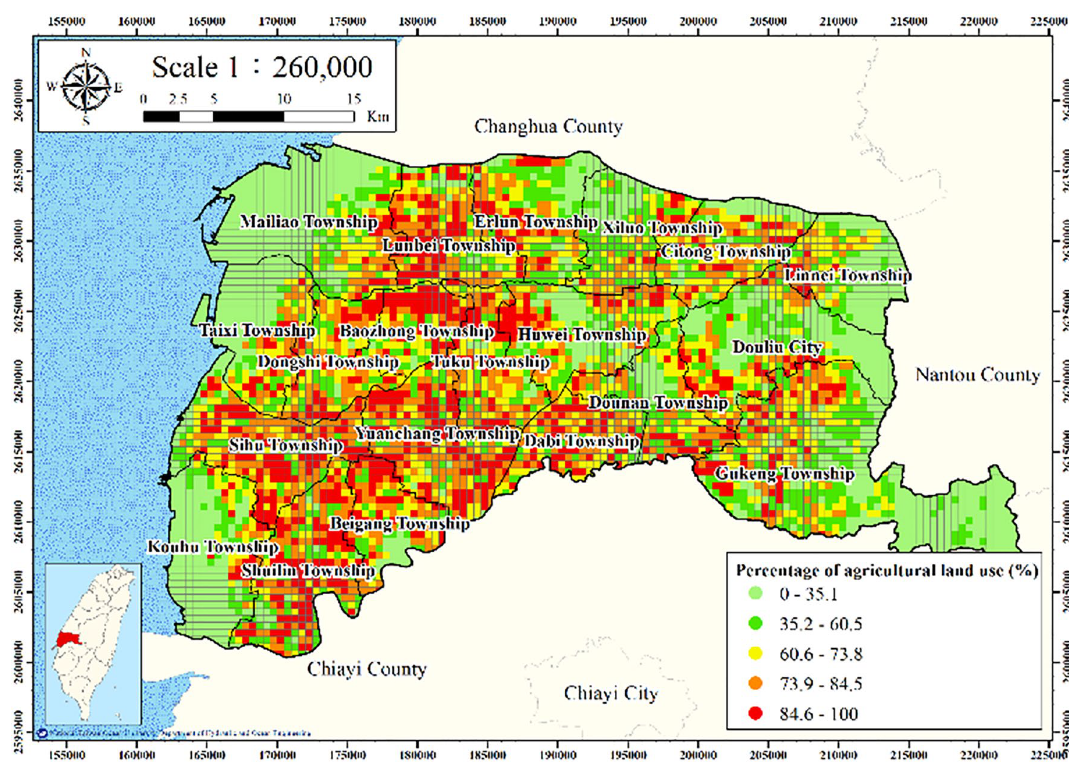
Figure 11. Cells of agricultural land use. This figure was created using ArcGIS 10.6.1 software.